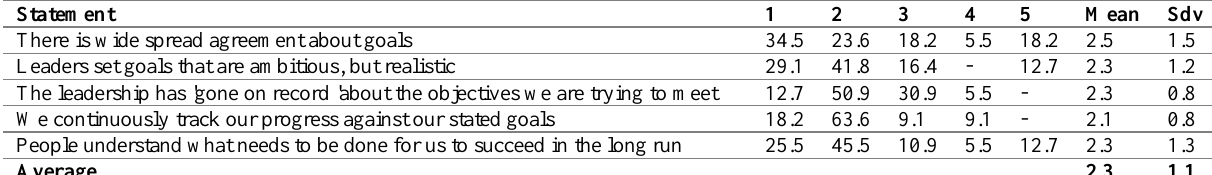
Table 3: Managers’ Perception on Goals and Objectives in their Hotels